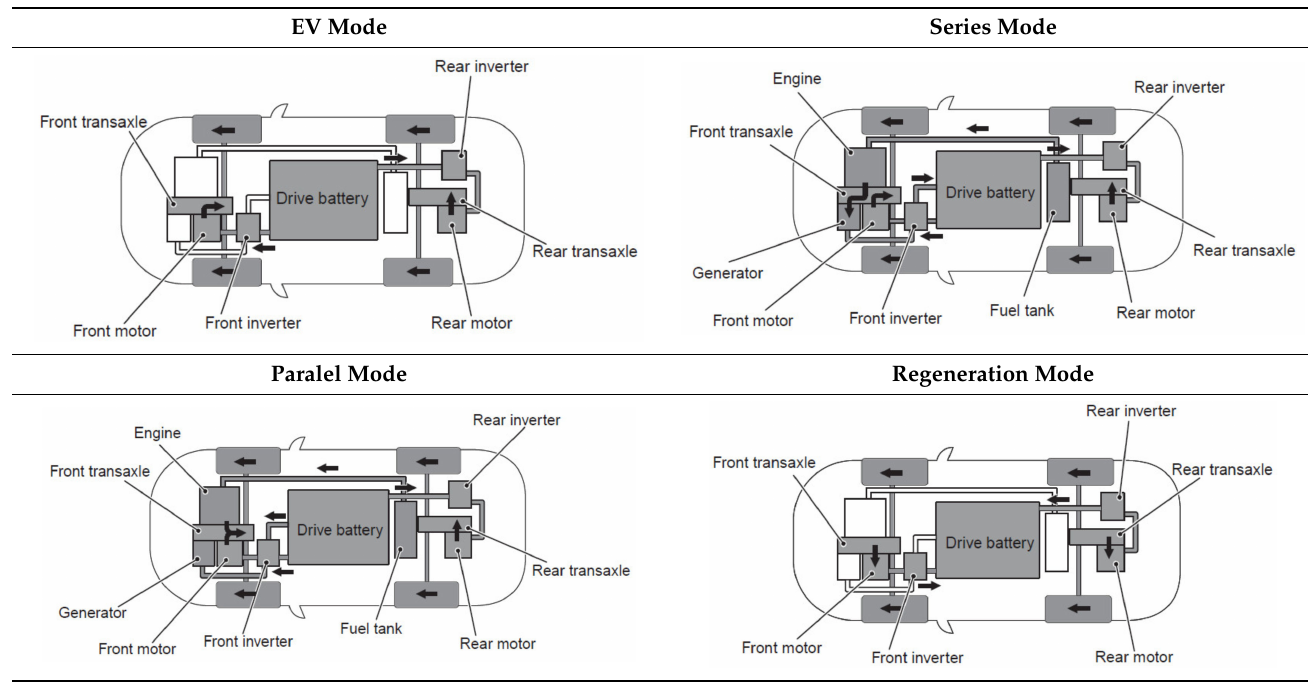
Table 1. Mitsubishi Outlander PHEV powertrain operation modes